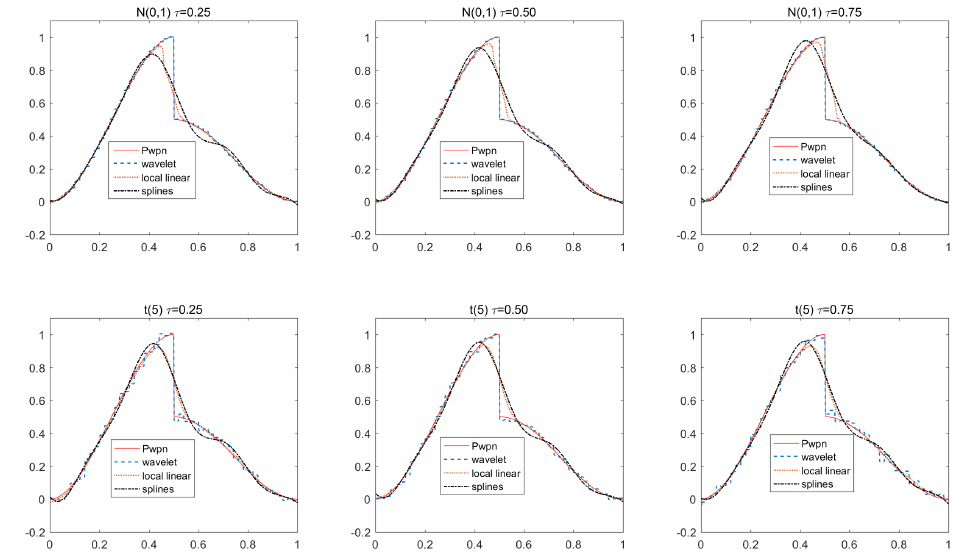
Figure 1. The true time-varying coefficient function Papw, and their QR-wavelet, QR-local-linear and QR-splines estimates when n = 300, and τ = 0.25, 0.50 and 0.75 for the errors N ( 0,1 ) and t ( 5 )